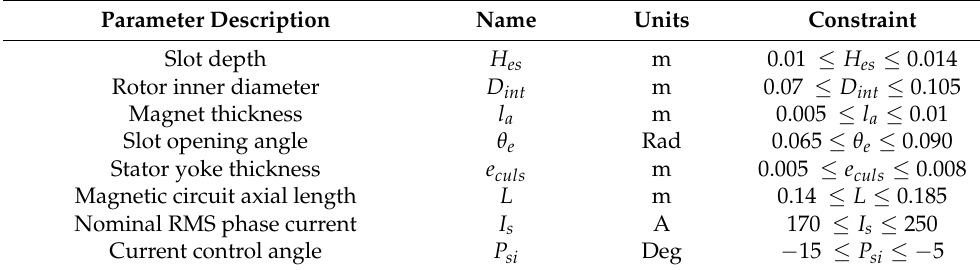
Table 7. Optimization variables for Direct FEA.